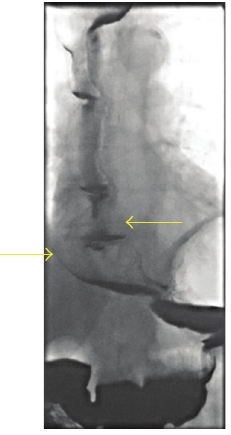
Figure 4: Barium swallow showing dilated lower oesophagus (no achalasia